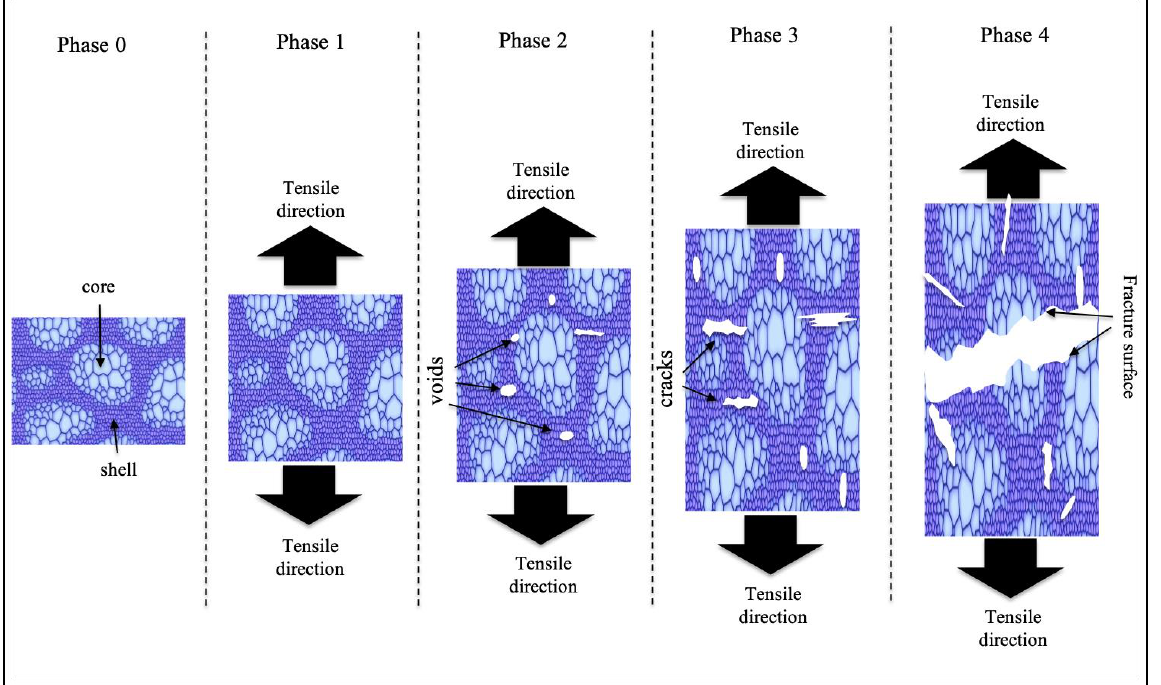
Figure 7. Fracture mechanism model of HS pure Cu.